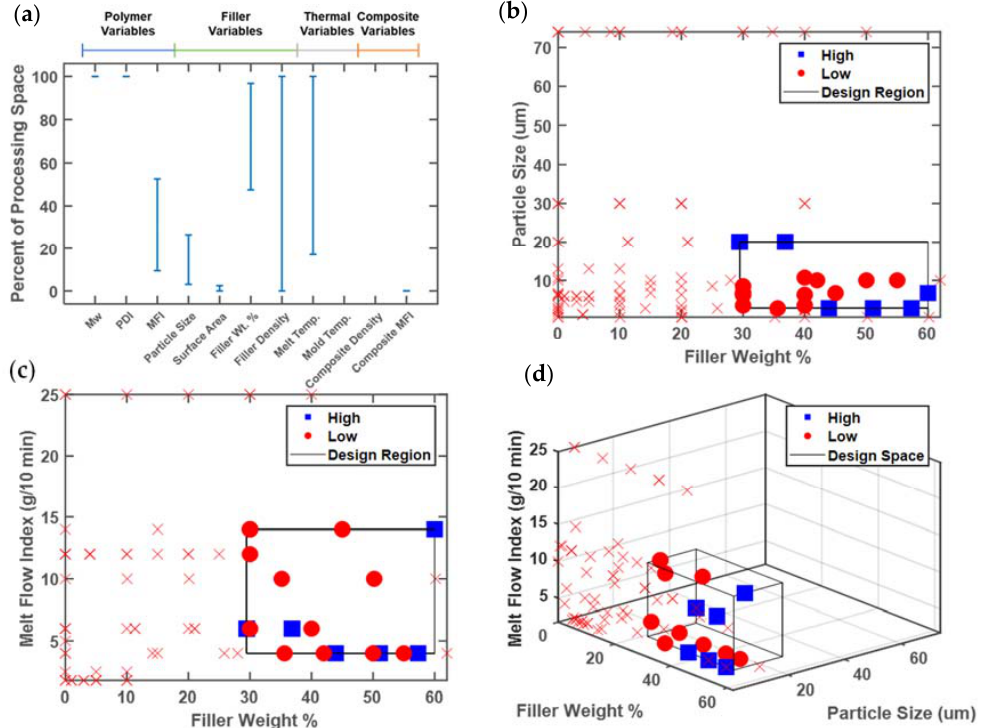
Figure 6. Representative analysis plots of ( a ) one ‐ , ( b , c ) two ‐ , and ( d ) three ‐ dimensional analysis, classifying design variables that result in Young’s modulus exceeding 5 GPa. All axis values denote the full range of values present in the database. Blue squares are data points above the cutoff, red dots represent points below the cutoff but within the target design region, and the red x markers indicate all other data points below the cutoff but not within the target design region.